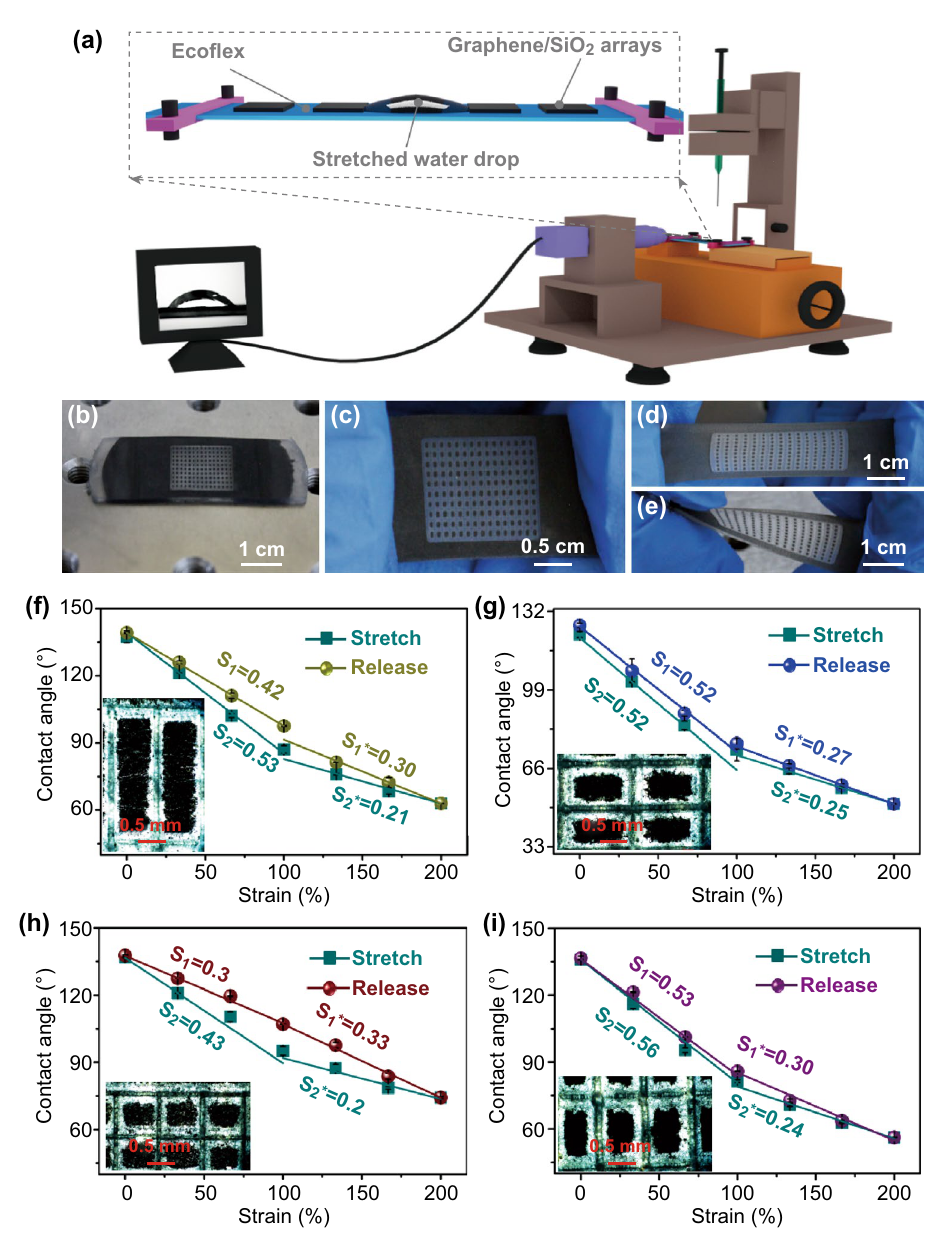
Fig. 2 a Schematic diagram of the measurement device for water contact angles of the tested films at different strains. b – e Photographs of the laser‑etched graphene/SiO 2 /Ecoflex composite films stretched by different strains. f – i Water contact angle–strain curves for the composites film with arrays of 15 × 5, 10 × 15, 15 × 15, and 15 × 10. The insets in f – i are the corresponding optical micrographs of the